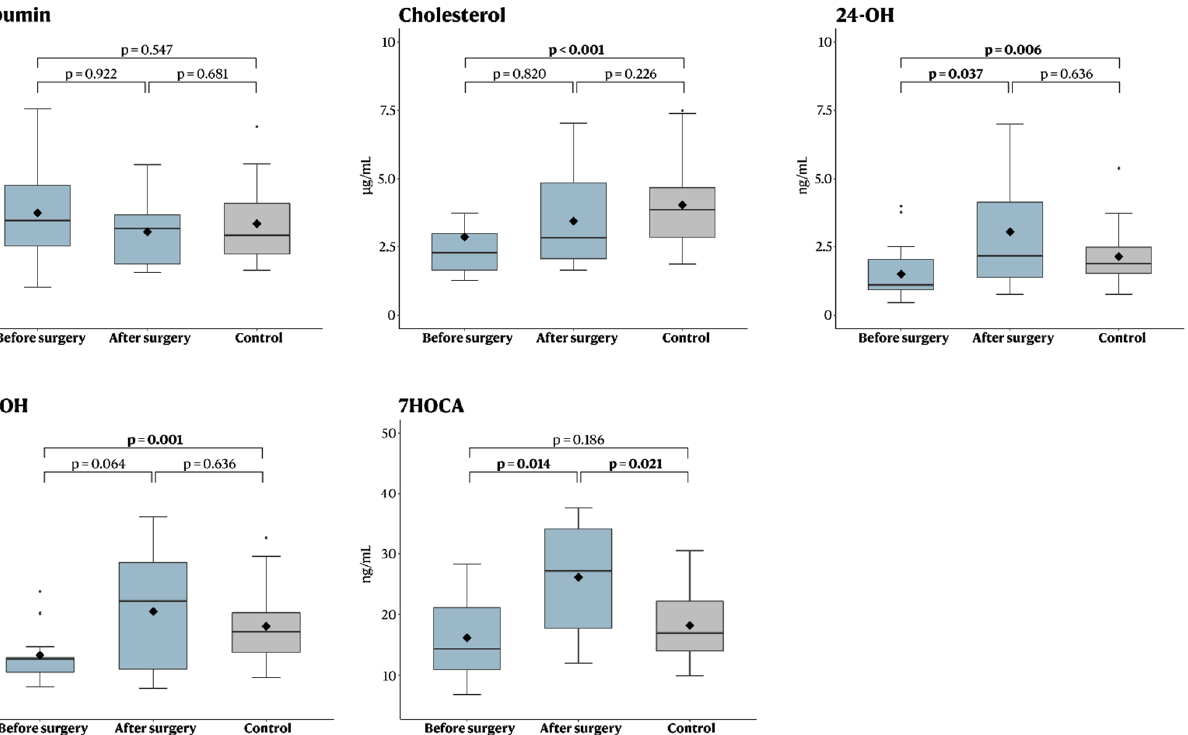
Figure 2. Boxplot showing concentrations before and after surgery, as well as compared to healthy controls. The Mann–Whitney U test was used to compare pre- and postoperative metabolites in the treatment group to non-treated controls (non-matched continuous data), and the Wilcoxon signed- ranks test was used to compare metabolites in each treated patient before and after surgery (matched continuous data). Table 2. Matched comparisons between metabolites before and after surgery. Oxysterol Before Surgery ( n = 10) After Surgery ( n = 10) p -Value Albumin (mg/L)